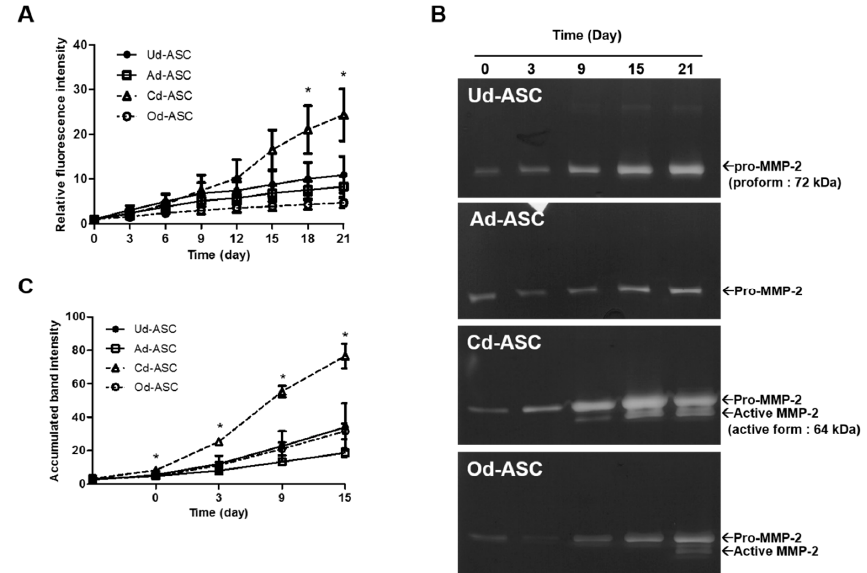
Figure 2. Proteolytic enzyme activity in hASCs during differentiation. ( A ) The proteolytic enzyme activities of Ud-ASC, Ad-ASC, Cd-ASC, and Od-ASC were detected by DQ-BSA; ( B ) the MMP-2 activities of Ud-ASC, Ad-ASC, Cd-ASC, and Od-ASC were measured by zymography. The molecular weight of MMP-2 pro-form is 72 kDa and the active form is 62 kDa; and ( C ) the quantitative data of accumulated band intensity of MMP-2, both pro-form and active-form. The band intensity (in panel B ) was measured by ImageJ software. The data are shown as the mean ± SEM ( n = 3, Ud-ASC vs. Cd-ASC, *: p < 0.05).